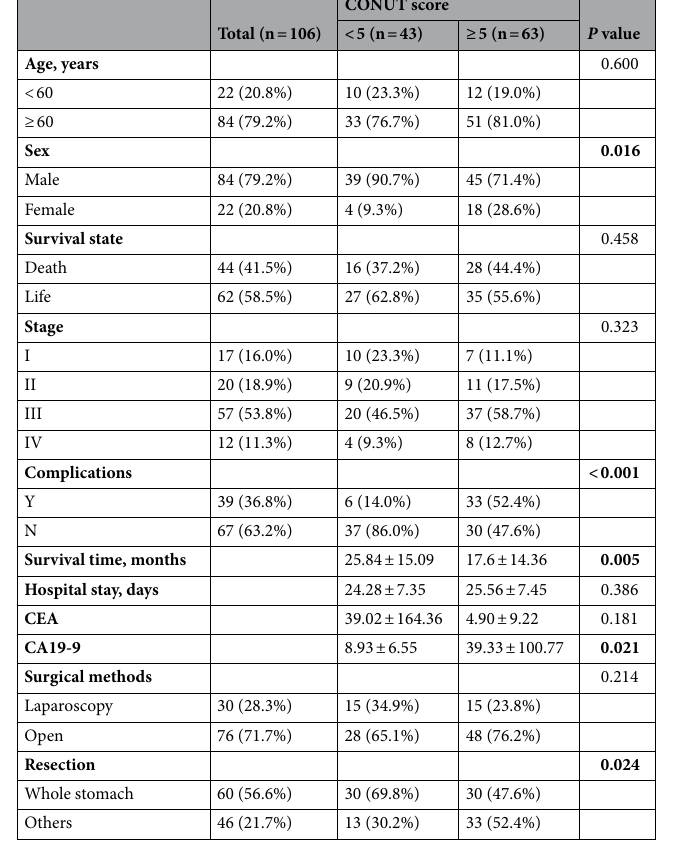
Table 1. Patient characteristics (n = 106).